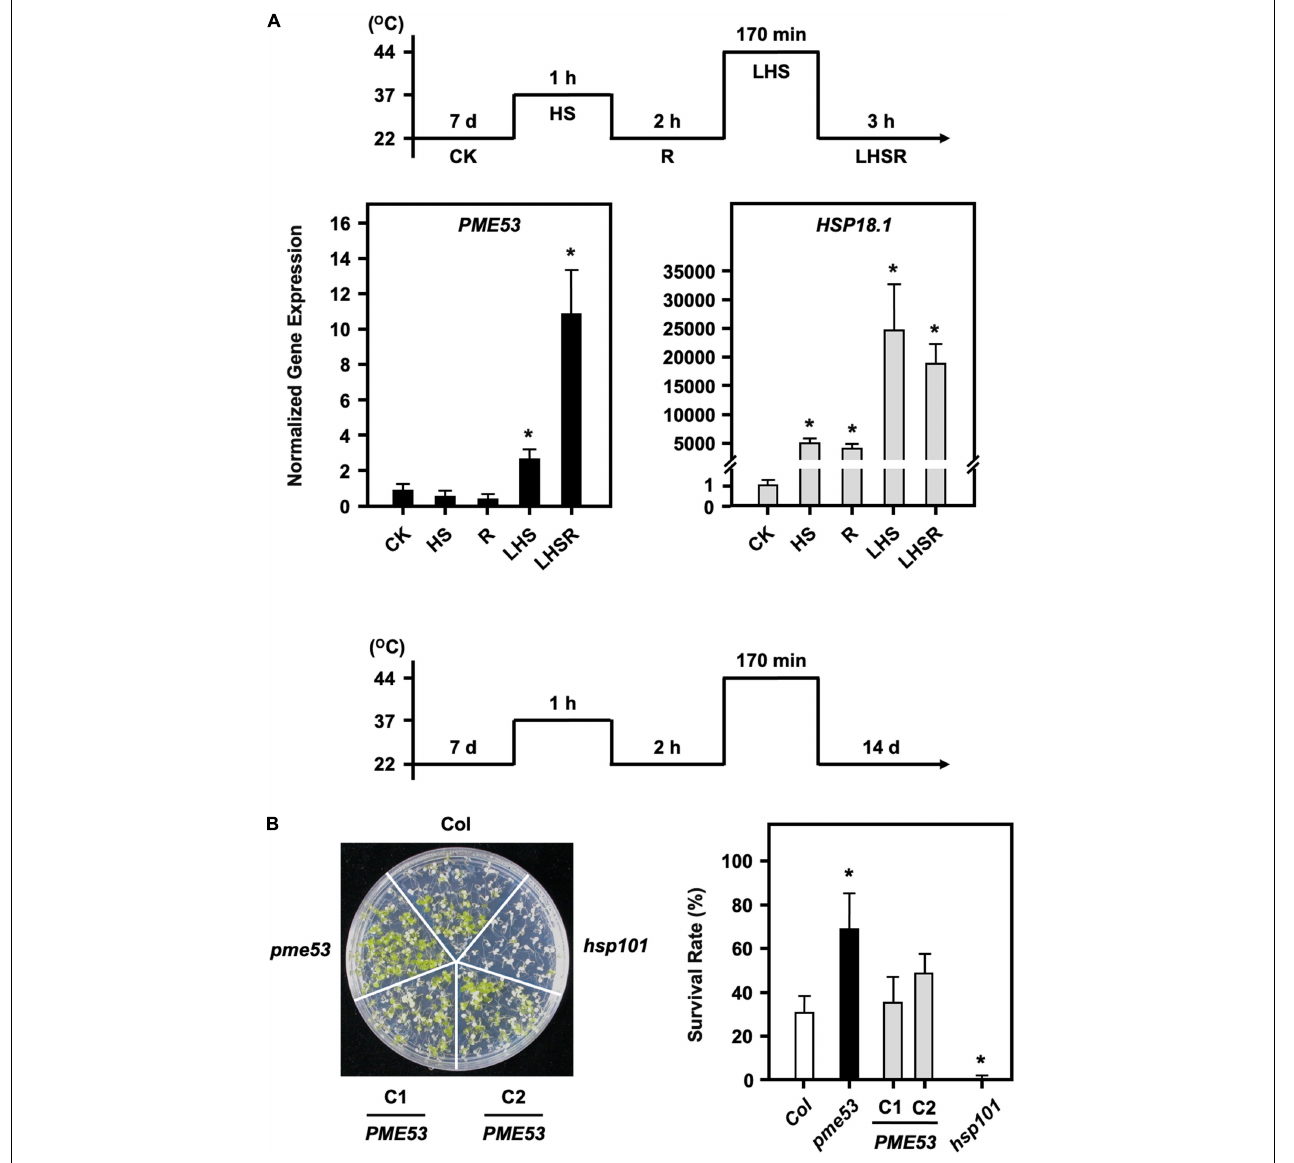
FIGURE 7 | pme53 mutant and its complementation lines in response to heat stress. The pictogram shows the heat stress regime. (A) The expression levels of PME53 in 7-day-old seedlings were analyzed by q-PCR. HSP18.1 , a heat-responsive gene, was used as reference. The fold change expression was normalized relative to the level of control (CK). Data are mean ± SE of three biological replicates. *Significant at P < 0.05 compared with the control. (B) Seedlings were photographed and survival was measured at 14 days after the LHS treatment. PME53 -C1 and -C2 are PME53 -complemented lines generated in pme53 background. hsp101 , a heat-sensitive mutant, was used as reference. Data are mean ± SE of three biological replicates ( n = 50 seedlings). *Significant at P < 0.05 compared with the